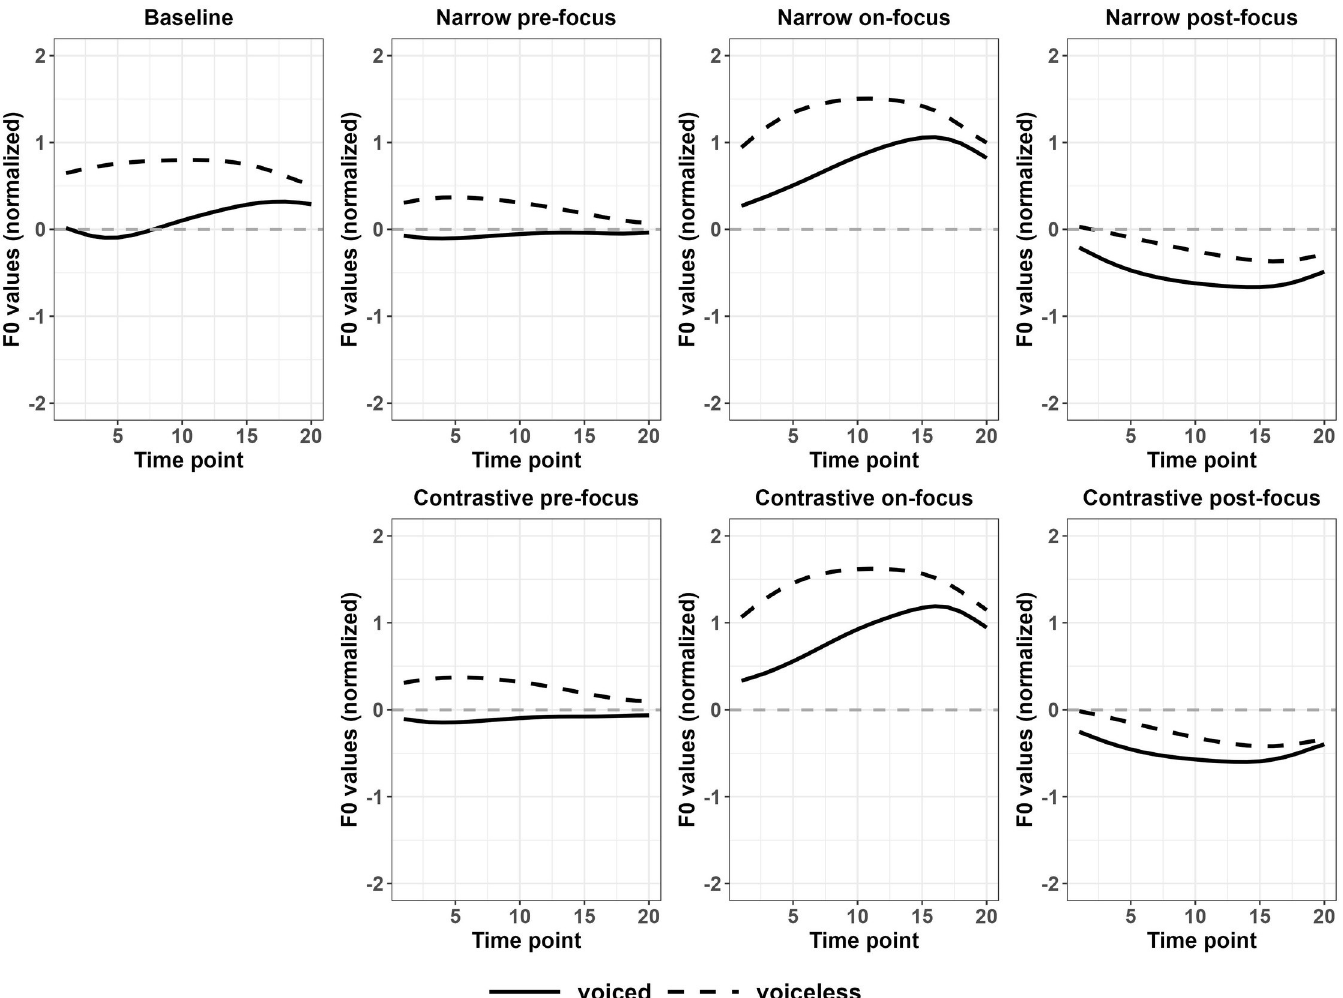
Fig 10. Normalized f0 contours of monosyllabic targets in various discourse conditions (Japanese).